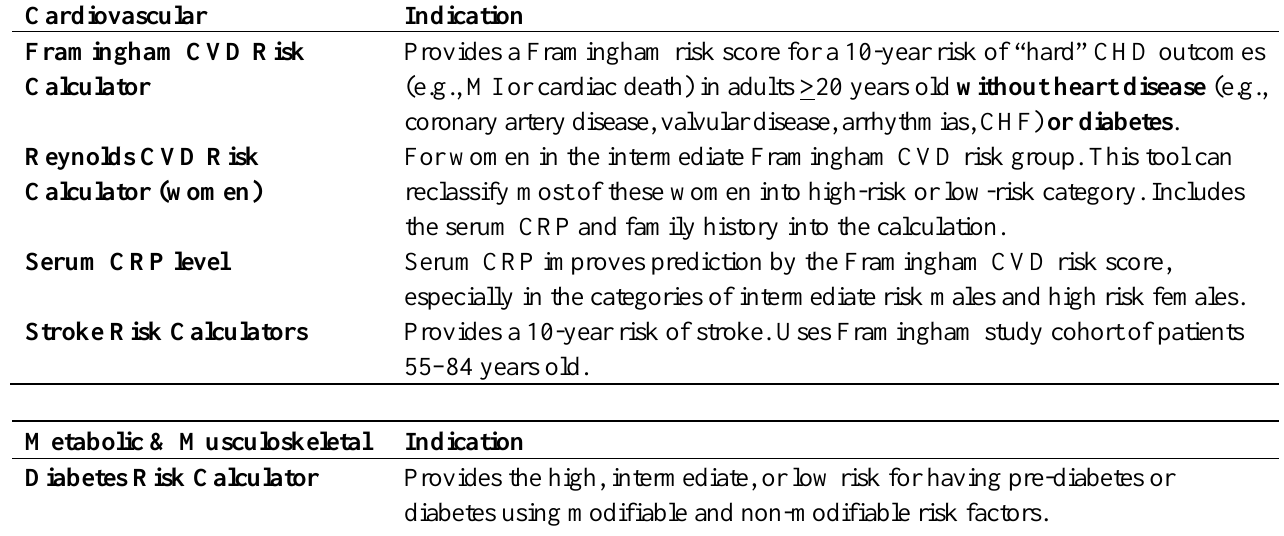
Table 1. Examples of the initial tools selected for health risk assessment and predication for the My PREVENT™